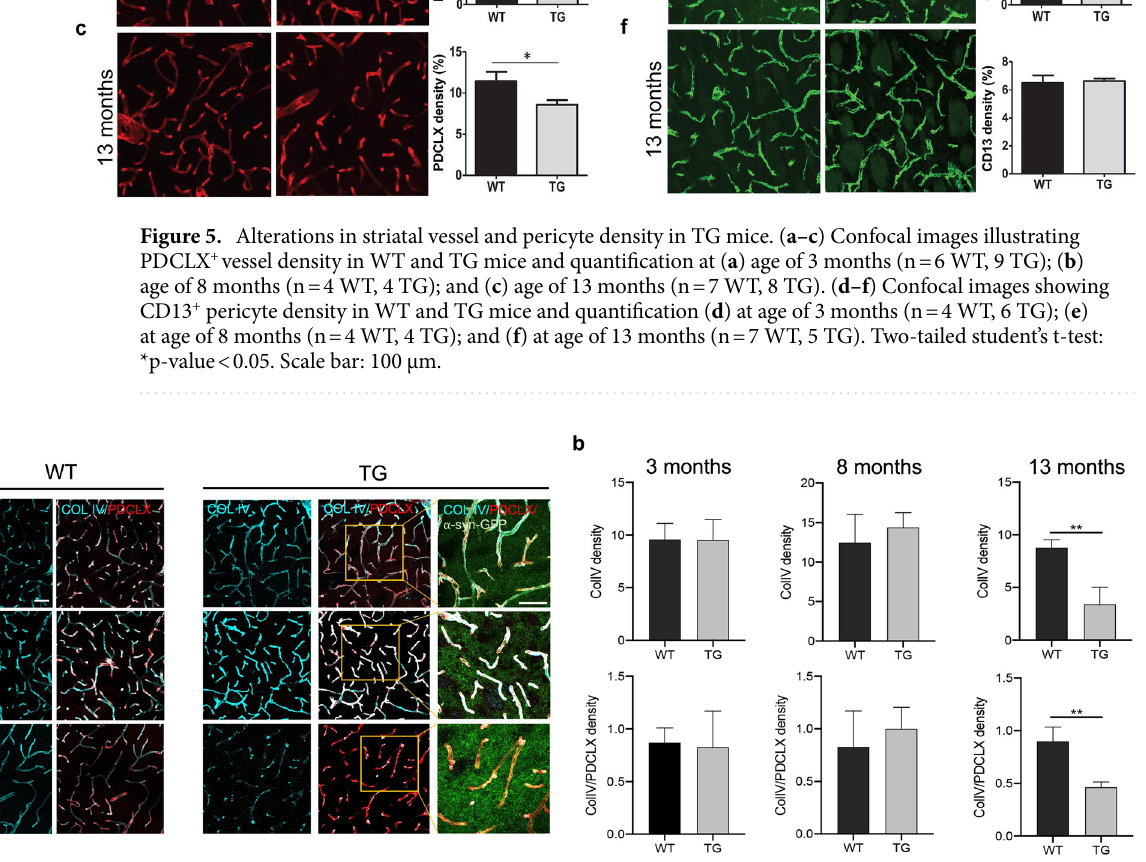
Figure 6. Reduction of Col IV in TG mice at late age. ( a ) Confocal images illustrating Col IV density and its proportion in relation to the PDCLX + vessels in WT (left panel) and TG mice (right panel). ( b ) Quantification of Col IV density and its proportion in relation to the PDCLX + vessels in WT and TG mice at age of 3 months (n = 3 WT, 3 TG); age of 8 months (n = 3 WT, 3 TG); and age of 13 months (n = 3 WT, 3TG). Two-tailed student’s t-test: *p-value < 0.05. Scale bar: 50 μm. PDCLX = Podocalyxin, Col IV = Collagen